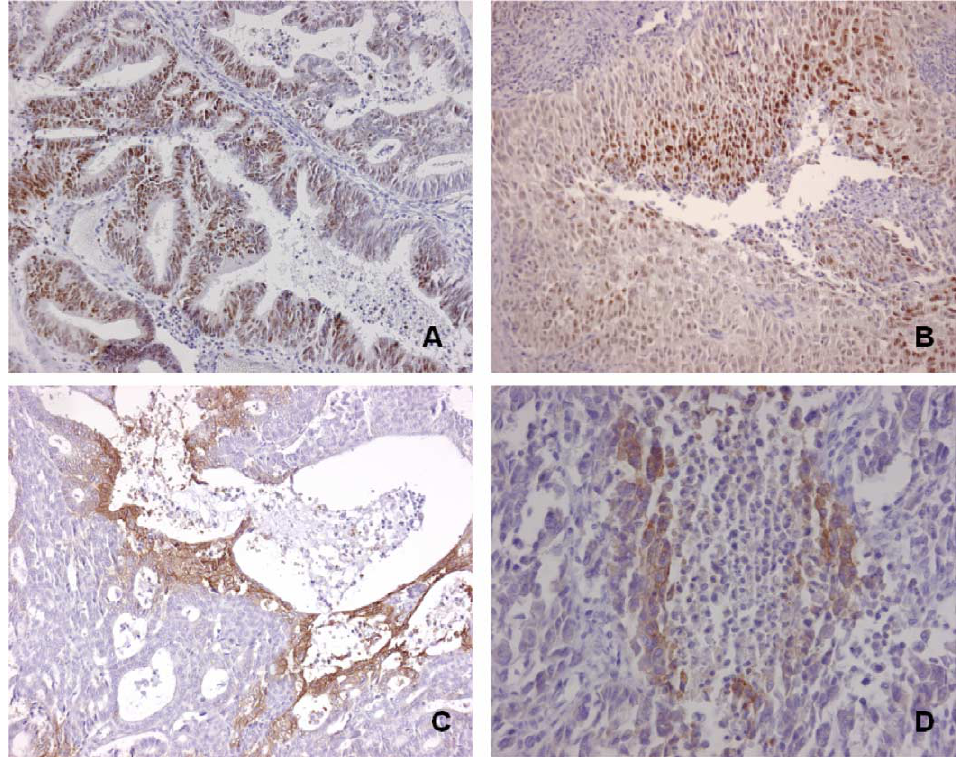
Fig. 1. Expression of HIF-1 α , Glut-1 and CAIX in endometrial carcinomas. (A) Diffuse nuclear expression of HIF-1 α (10 × magnification). (B) perinecrotic nuclear expression of HIF-1 α (20 × magnification). (C) Perinecrotic membrane CAIX expression (10 × magnification). (D) Perinecrotic membrane Glut-1 expression (20 ×